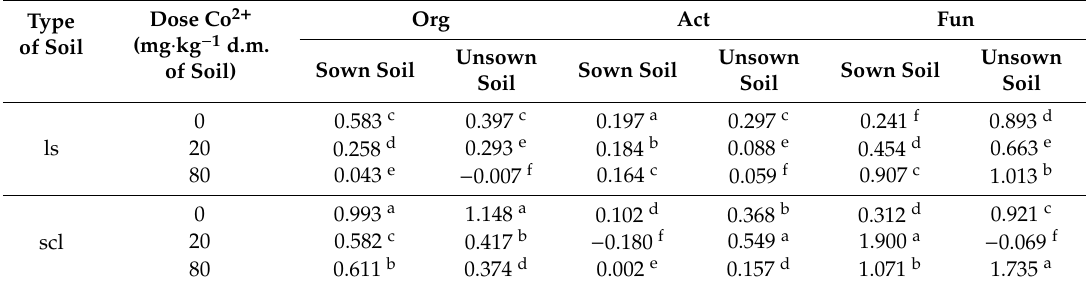
Table 8. Index of molecular sieve e ff ect ( IF s ) on the microorganism count in soil.